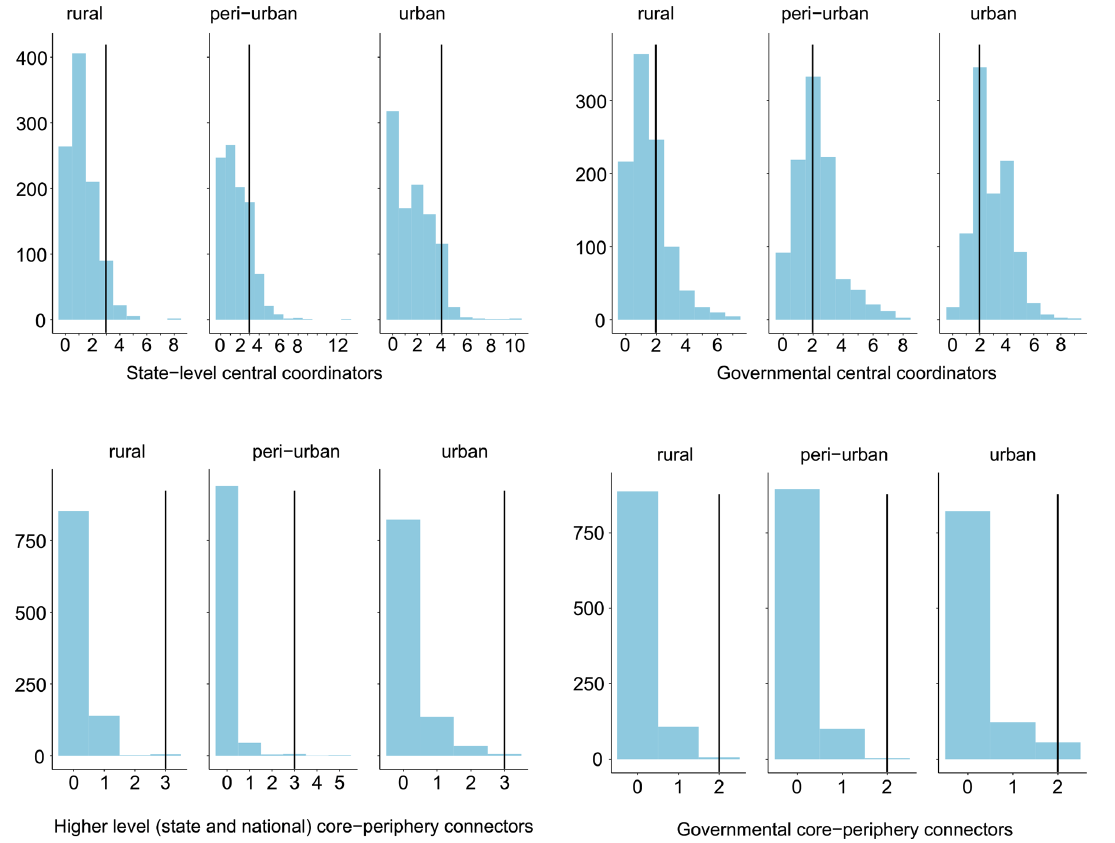
Fig. 3 . Frequency (count) of the occurence of four actor types in three Swiss water supply governance networks. The solid lines show the real, observed number of each actor type. The bars illustrate the distribution obtained from 1000 simulated networks based on a pooled exponential random graph model of the networks. The more the solid line deviates to the right from the distribution, the more likely it is that the given actor type is observed more often than by